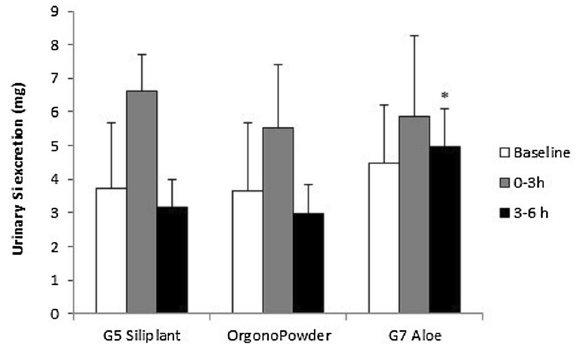
Figure 2. Urinary Si excretion at baseline and over the two collection time periods (0–3 h and 3–6 h) after administration of G5 Siliplant (liquid presentation), Orgono Powder (powder presentation) and G7 Aloe (liquid presentation; all containing 21.6 mg of Si) in healthy subjects. The results are expressed as total milligrams excreted in urine. Values are the mean ± SD (n = 5) *, p < 0.05 with respect to G5 Siliplant and Orgono Powder at the same time